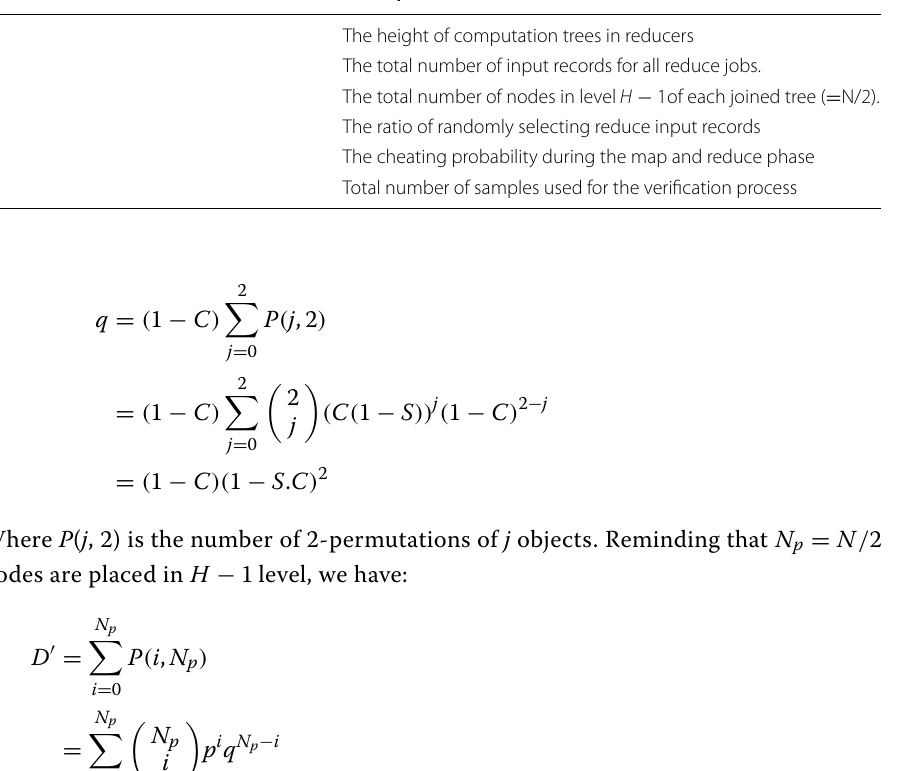
Table 1 Notations used in the evaluation and analysis discussions